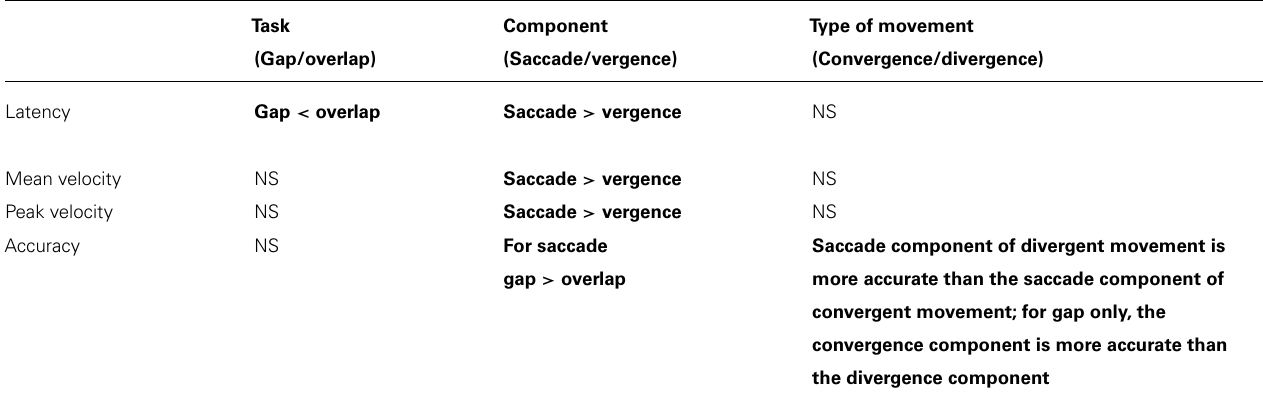
Table 3 | Summary of the statistically significant results (in bold) for the effect of task (gap/overlap), component (saccade/vergence), and type of movement (convergent/divergent) for each parameter (latency, mean velocity, peak velocity, and accuracy).